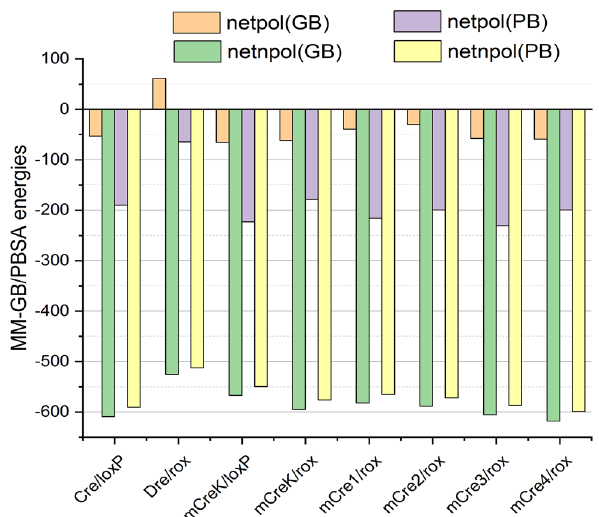
Figure 6. Net free energy component analyses of the studied complexes; net pol(GB/PB) : net polar contributions from MM-GBSA/MM-PBSA (net pol(GB/PB) = ΔE ele + ΔG GB/PB ), net npol(GB/PB) : net non-polar contributions from MM-GBSA/MM-PBSA (net npol(GB/PB) = ΔE vdW + ΔG SA(GB/PB)